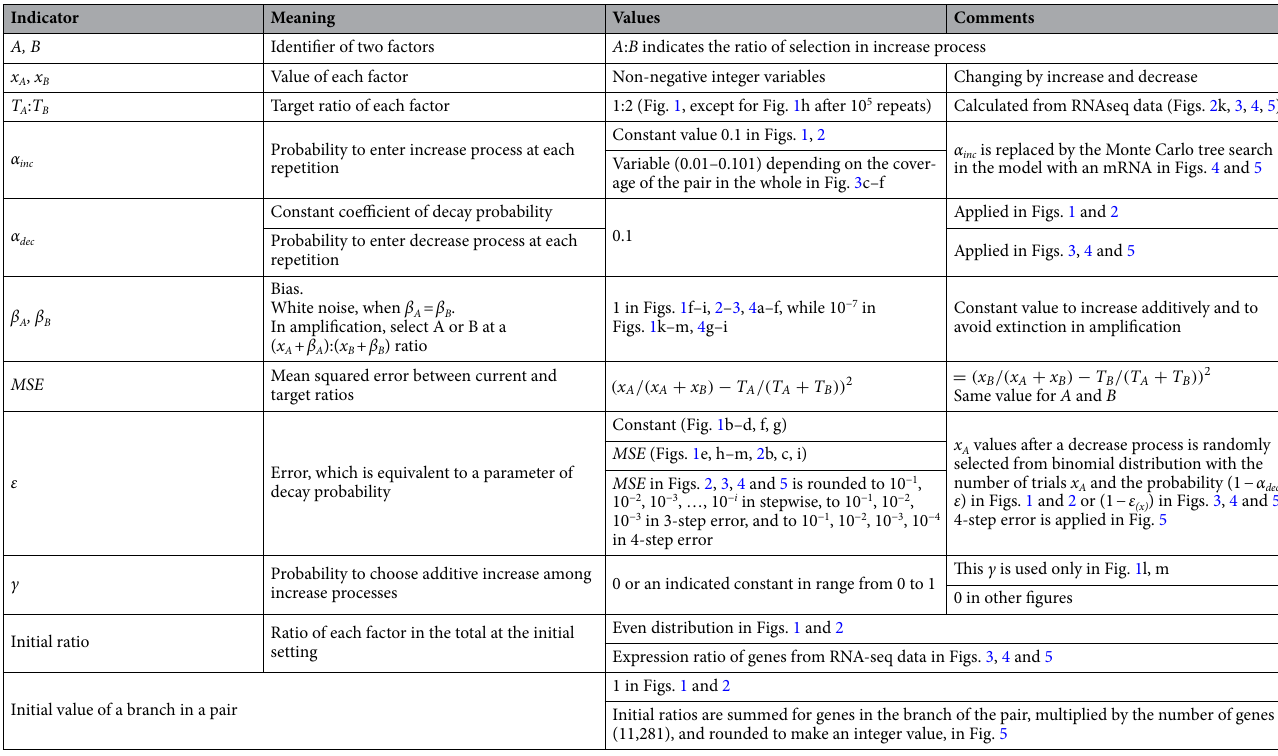
Table 1. Variables and parameters in the models. In the learning pair model, the values of two factors, x A and x B , repeat stochastic processes of increase and decrease. In the increase process, either A or B is selected, and the value of the selected factor increases by one. In the increase process, competitive amplification or additive increase is chosen at (1 − γ ): γ ratio. In competitive amplification, A or B is selected at the ( x A + β A ):( x B + β B ) ratio. In the additive increase, A or B is selected at a 1:1 ratio. In the decrease process, x decreases by decay at a probability depending on the error value